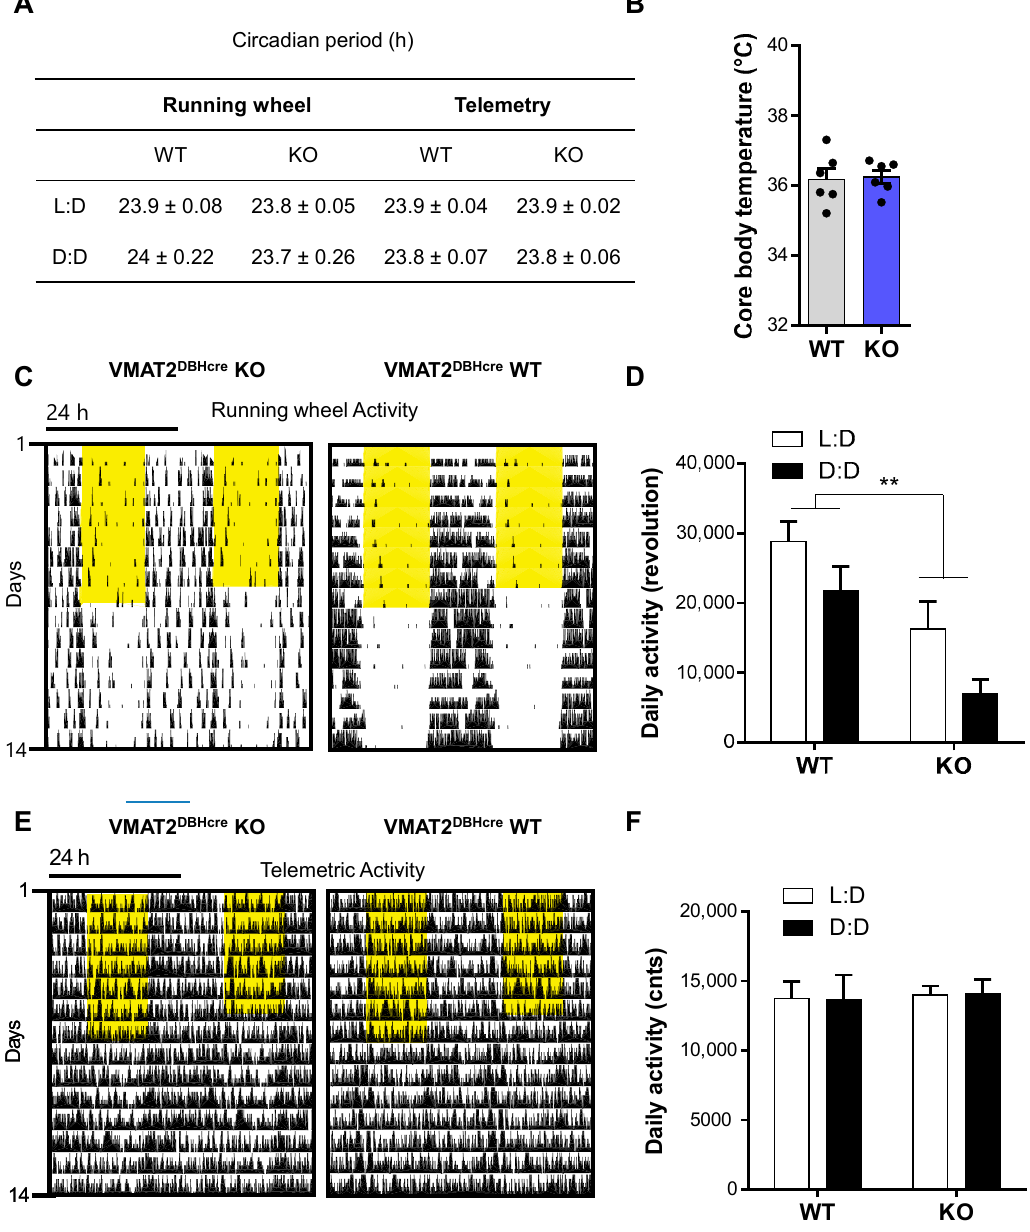
Figure 5. Circadian rhythmicity in VMAT2 DBHcre mice. ( A ) Average circadian locomotor period derived from chi-squared periodogram analysis of 7-day time-spans during light/dark (L:D) cycles and constant darkness (D:D) derived from home cage running wheel activity (genotype: F (1,16) = 0.77, p = 0.39, cycle: F (1,16) = 0.01, p = 0.91, genotype × cycle: F (1,16) = 0.22, p = 0.64) or telemetry implants (genotype: F (1,10) = 0.0, p = 1, cycle: F (1,10) = 11.6, ** p = 0.006, genotype × cycle: F (1,10) = 0.0, p =